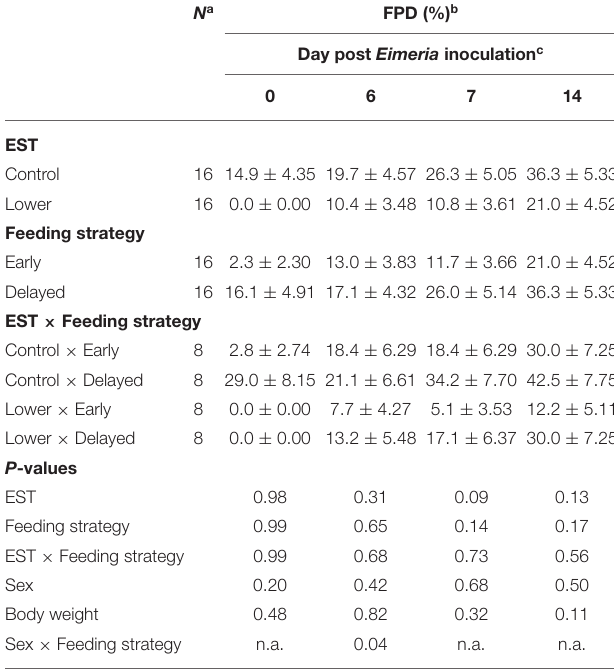
TABLE 6 | Effect of eggshell temperature ( EST ) during late incubation [ ≥ embryonic days 17–19.5; 37.8 ◦ C ( control ) or 36.7 ◦ C ( lower )] and/or feeding strategy after hatch [immediate access to feed and water ( early ) or 51–54h deprivation ( delayed )] on average footpad dermatitis (FPD) incidence of broilers at d 0, 6, 7, or 14 post Eimeria inoculation (d 21 post hatch) to induce necrotic enteritis (mean ±